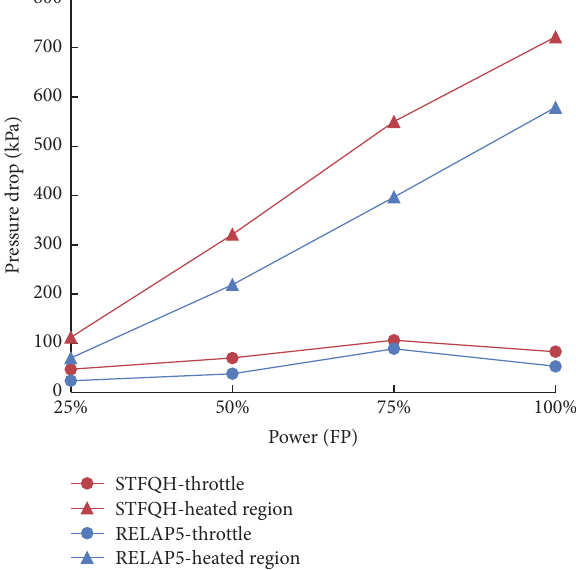
Figure 6: RELAP5 nodalization of a countercurrent H-OTSG with two parallel heated pipes.